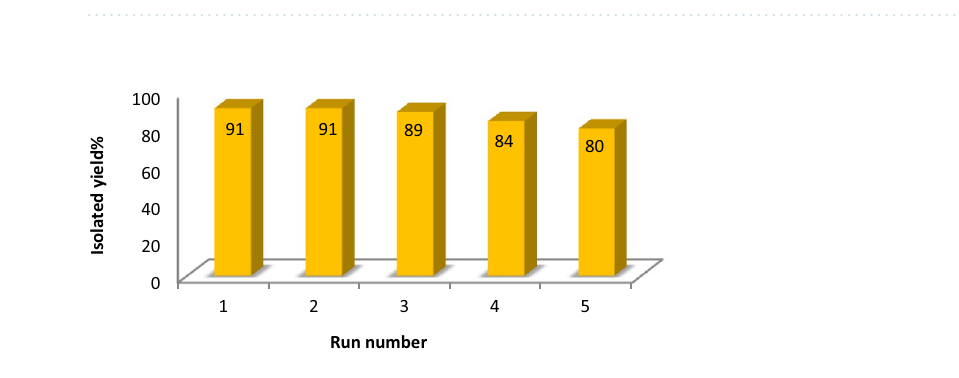
Figure 25. Recyclability of HMS/Pr-Xa-Ni in the synthesis of 2-amino–4-(4-chlorophenyl)-3–cyano-7,7–